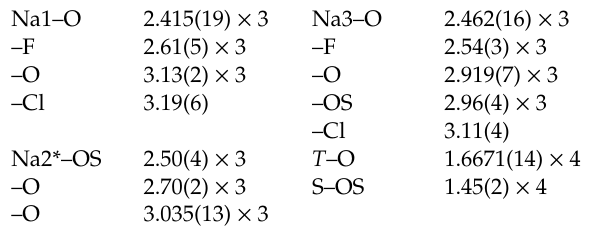
Table 6. Selected interatomic distances (Å) in the structure of Sample 9.